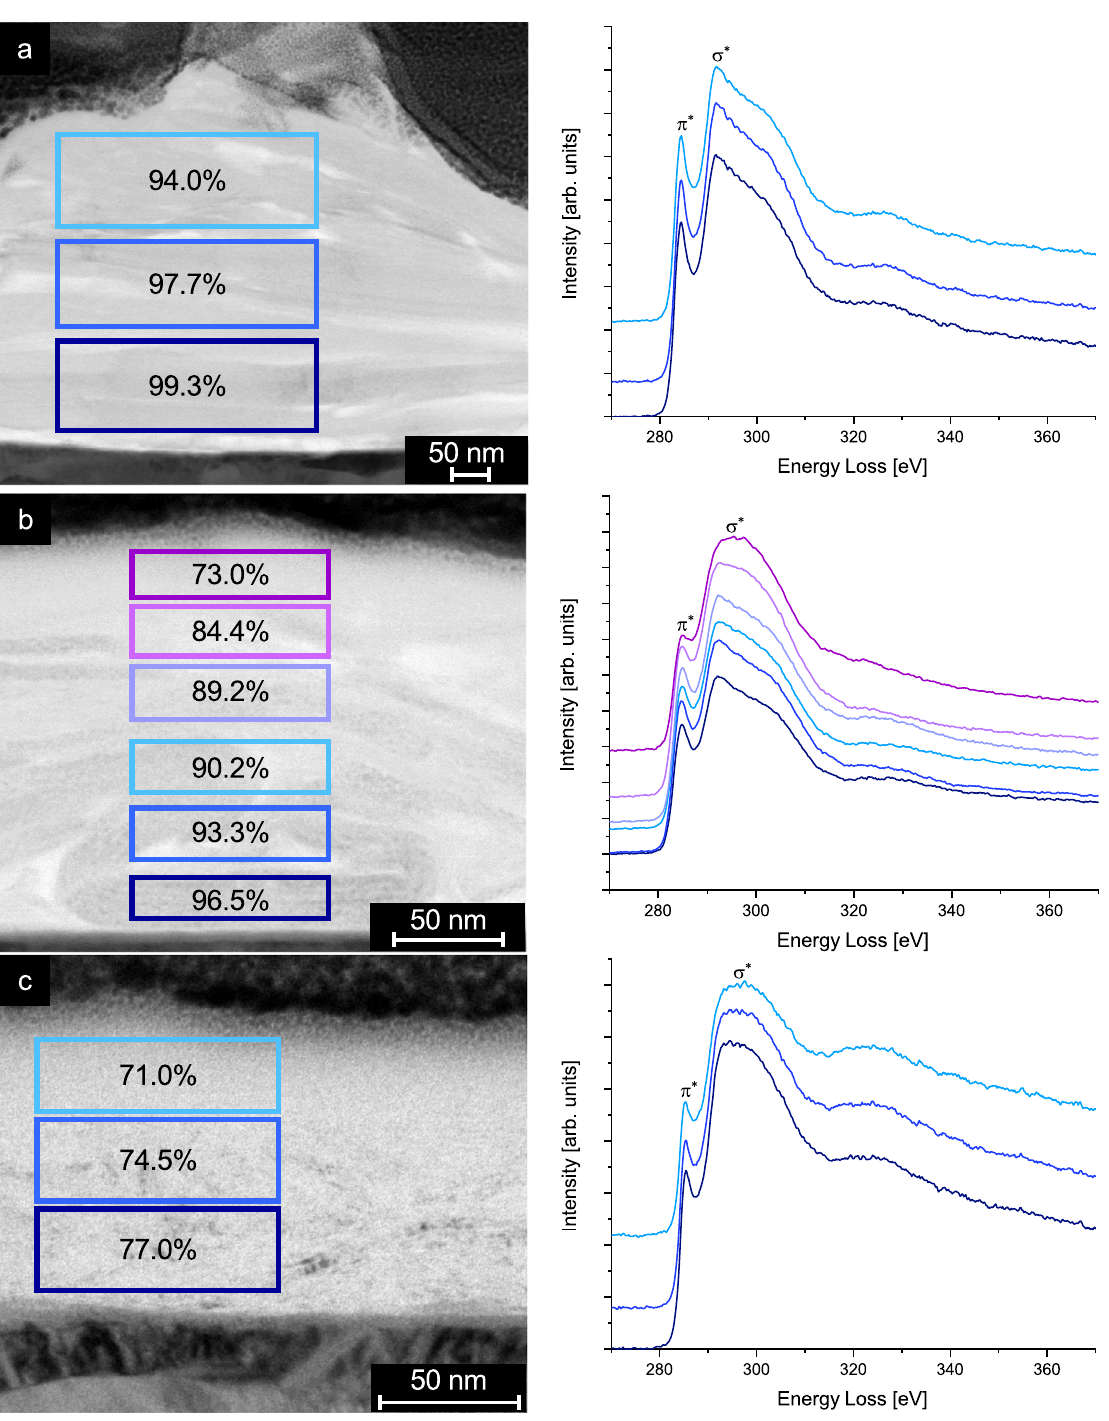
c graphite after sliding experiment at1GPa.The error for the determination ofthe sp 2 content is estimated to be 2%. For the sample at 50MPa six ROI were taken instead of three, as the TEM analysis exhibited a more changing morphology throughout the whole layer than the other